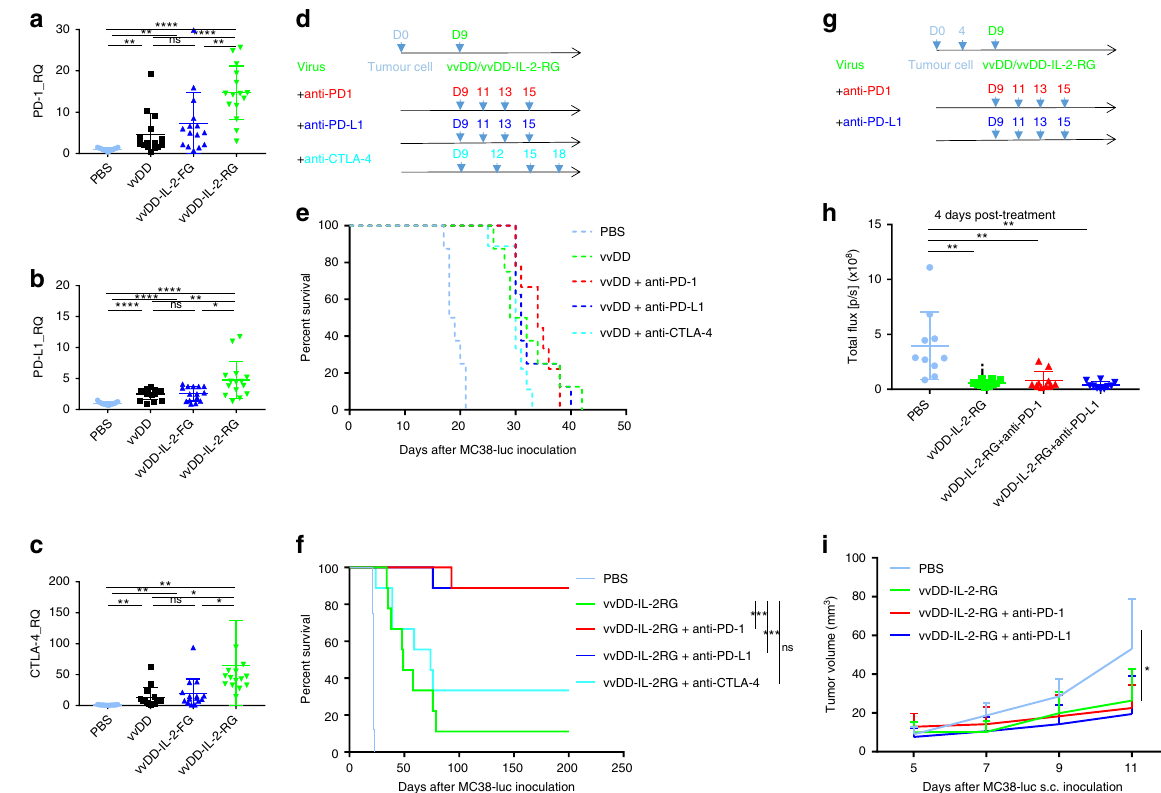
Fig. 4 Combining vaccinia virus expressing IL-2 with immune checkpoint therapy. B6 mice were inoculated with 5 × 10 5 MC38-luc cells and treated with PBS, vvDD, vvDD-IL-2-FG, or vvDD-IL-2-RG at 2 × 10 8 PFU per mouse 9 days post-tumour inoculation. Tumour-bearing mice were sacri fi ced 5 days post- treatment and primary tumours were collected and analysed using RT-qPCR to determine the expressions of PD-1 ( a ), PD-L1 ( b ), and CTLA-4 ( c ) in the tumour microenvironment. Five mice were used for each treatment group in one experiment and data are combined from three independent experiments. In a separate experiment, B6 mice were i.p. inoculated with 5 × 10 5 MC38-luc cells and treated with vvDD/vvDD-IL-2-RG or PBS 9 days post-tumour inoculation. Anti-PD-1 Ab (200 µ g per injection), anti-PD-L1 Ab (200 µ g per injection), or anti-CTLA-4 Ab (100 µ g per injection) were i.p. injected into mice as scheduled (nine mice per group) ( d ), and a log-rank (Mantel-Cox) test was used to compare survival rates ( e , f ). In some experiments, to measure the abscopal effect, B6 mice were also s.c. inoculated with 5 × 10 5 MC38-luc 4 days after i.p. tumour inoculation, and treated with i.p. vvDD-IL-2-RG alone or combined with α -PD-1/PD-L1 Ab as scheduled (ten mice per group) ( g ) to monitor s.c. tumour growth ( h , i ). * P <0.05; ** P <0.01; *** P <0.001; and **** P <0.0001. ns: not signi fi